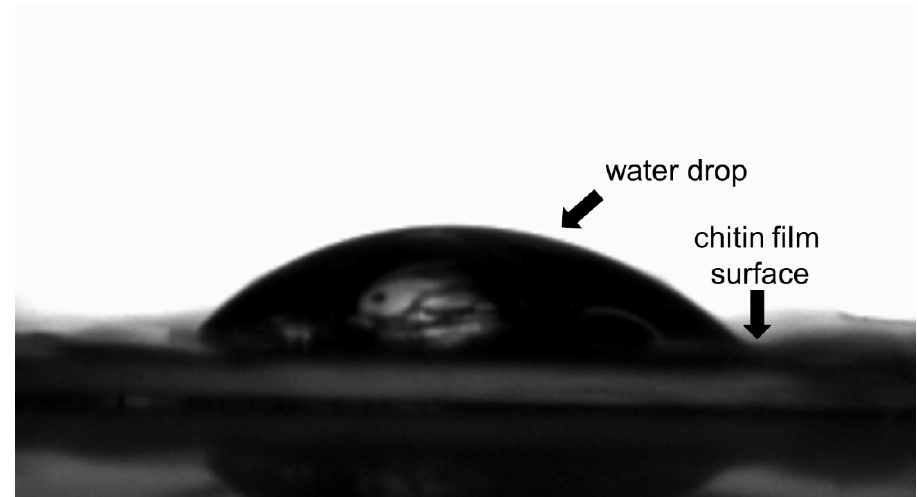
Figure 8. Photograph of the water drop in contact with the surface of chitin film.